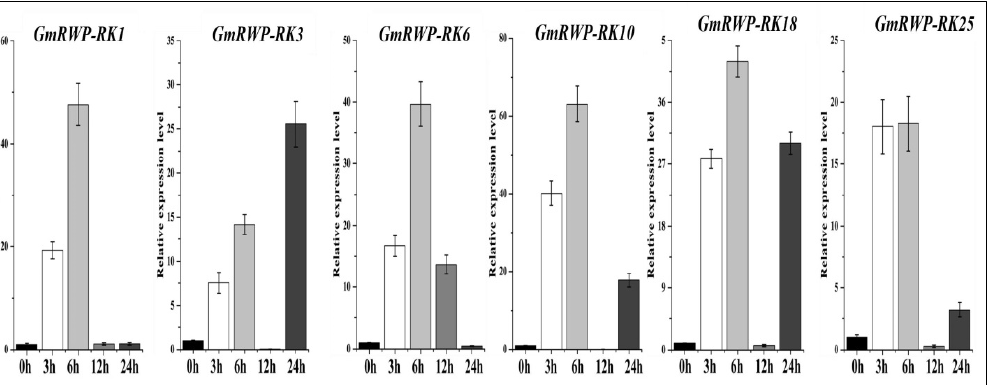
Figure 10. Relative expression level of GmRWP ‐ RK genes in response to salt stress at different time points using qRT ‐ PCR analysis. The different colored bars represent different time periods from (0–24 h). Error bars show the ±SE from three independent biological replicates.